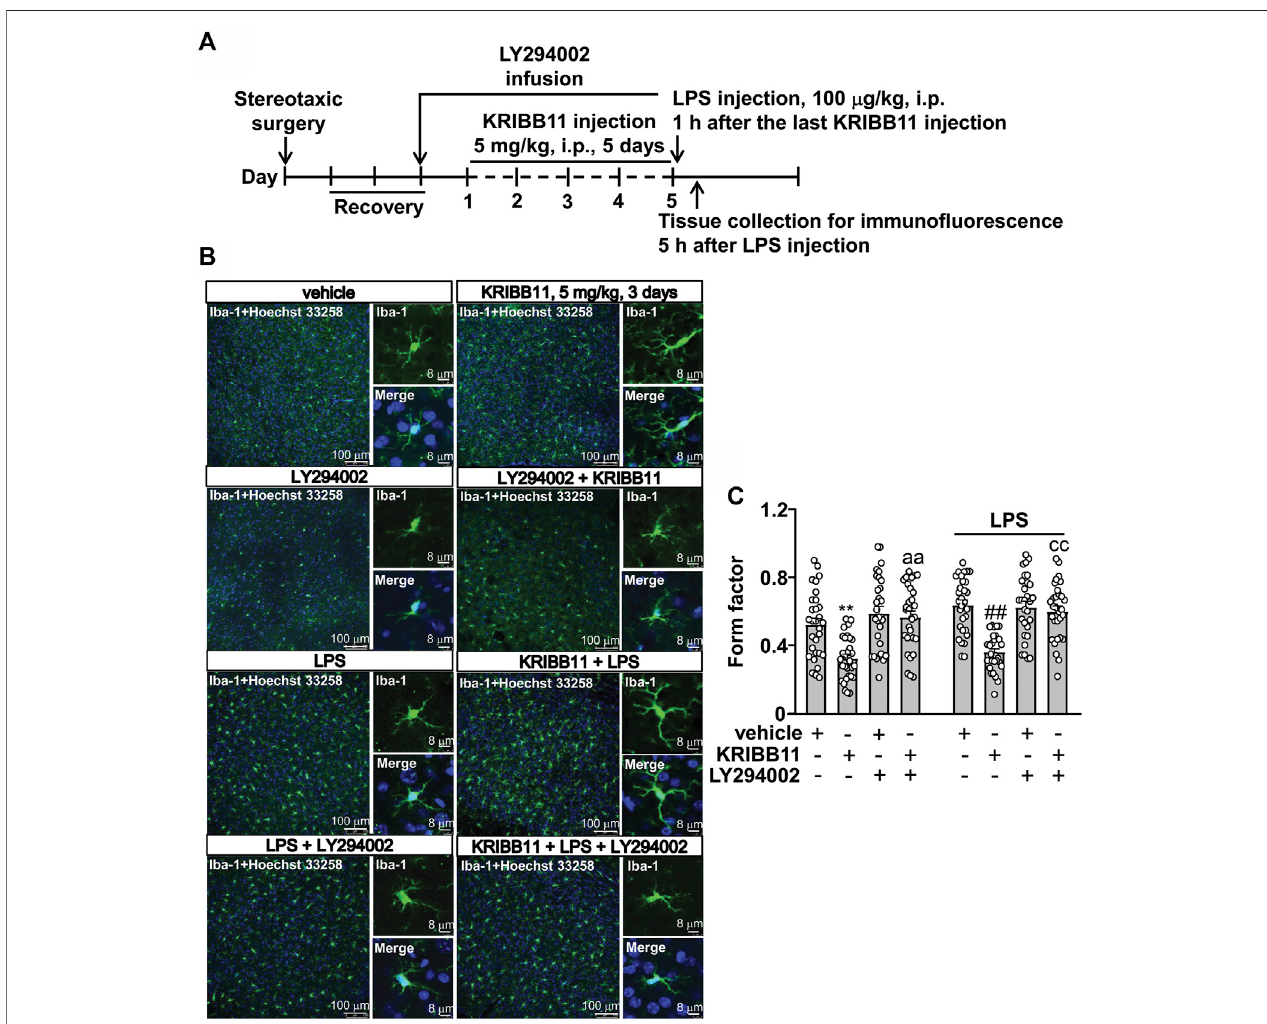
FIGURE 8 | LY294002 infusion abrogates the pro-elongation effect of KRIBB11 on microglial process in the dorsolateral prefrontal cortex in mice treated with or without LPS. (A) Time-line showing the investigation of the effects of intracerebroventricularly LY294002 infusion on the pro-elongation effect of KRIBB11 on microglial process in the dorsolateral prefrontal cortex in mice treated with or without LPS. (B,C) Representative images (B) and quantitative analysis (C) showed that intracerebroventricularly LY294002 infusion abrogated the pro-elongation effect of KRIBB11 on microglial process in the dorsolateral prefrontal cortex in mice treatedwithorwithoutLPS(** p < 0.01vs.vehicle,## p < 0.01vs.vehicle+LPS,aa p < 0.01vs.KRIBB11,cc p < 0.01vs.KRIBB11+LPS).Forcellshapeinvestigation,30 cellsperconditionwereanalyzedinthreeindependentexperiments.Scalebarsinthelowandhighmagni fi cationimagesare100and8 μ m,respectively.Dataareshown as mean ±